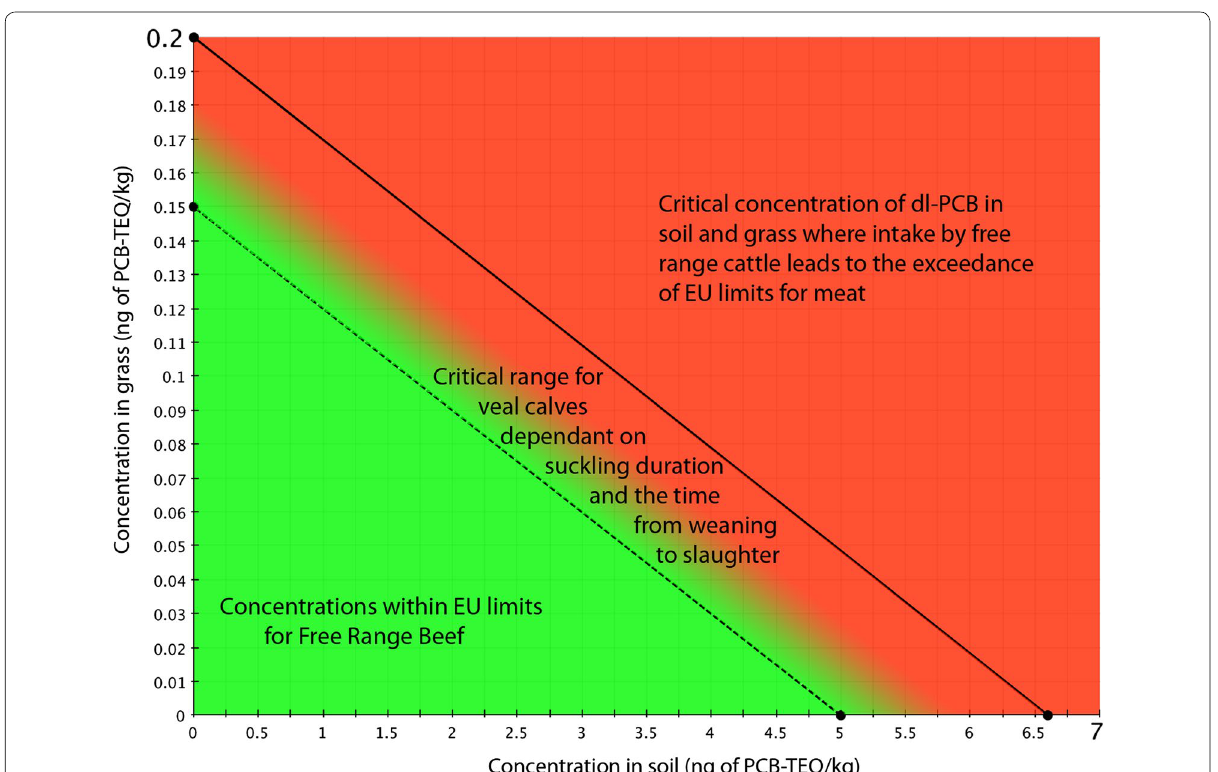
Fig. 2 Cumulative impact of grass and soil contaminated with dl-PCBs on exceedance of EU maximum levels for the sum of dioxins and dl-PCBs in beef and veal from suckling calves. Concentrations above the solid line are critical for beef and concentrations above the dashed line are critical for veal from suckling calves